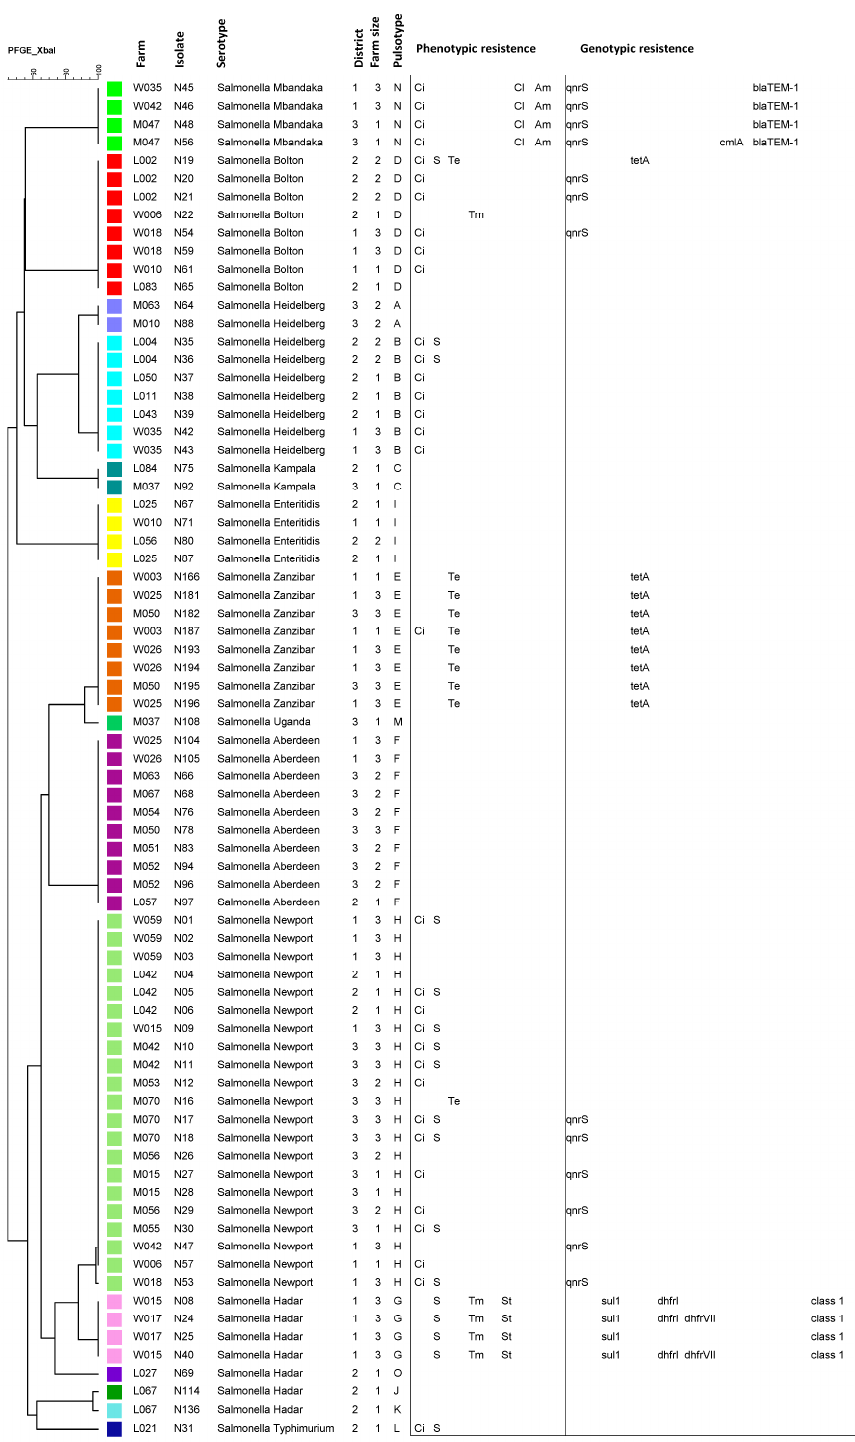
Figure 1. Dendrogram based on Pulsed-Field gel electrophoresis (PFGE) patterns of 75 non-typhoidal Salmonella from poultry from Uganda. A cutoff level of 97% similarity defines a PFGE profile. For each isolate the isolate number, PFGE profile, serotype, farm, size of farm, district, phenotypic resistance (Ci; ciprofloxacin, S; sulphonamide, Te; tetracycline, Tm; trimethoprim, St; sulphamethoxazole_trimethoprim, Cl; chloramphenicol, Am; ampicillin) and identified genotypic resistance genes ( qnrS, sul1, tetA, dhfrI, dhfrVII, cmlA , bla TEM-1 , integrons, dfrA15, aadA1 ) have been included.